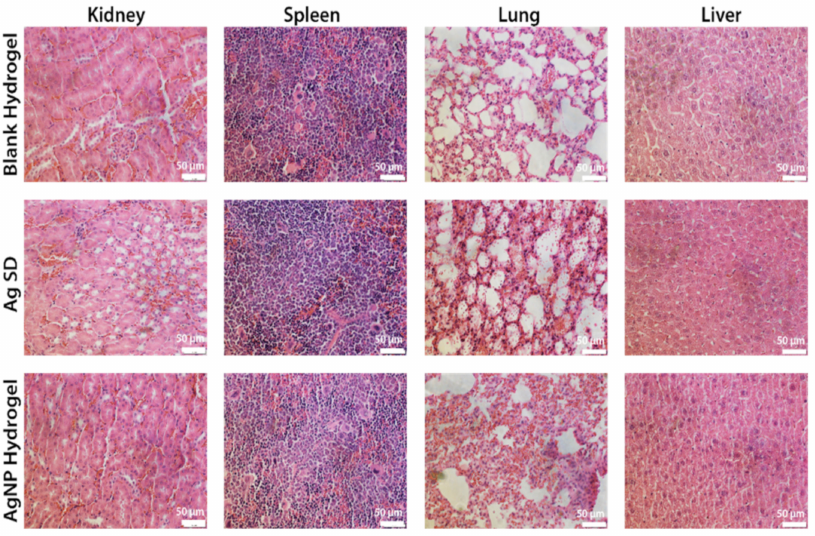
Figure 9. Hematoxylin-eosin (H&E) staining of the major organs after 10 days of different treatments, Scale bar 50 µ m, n = 8.